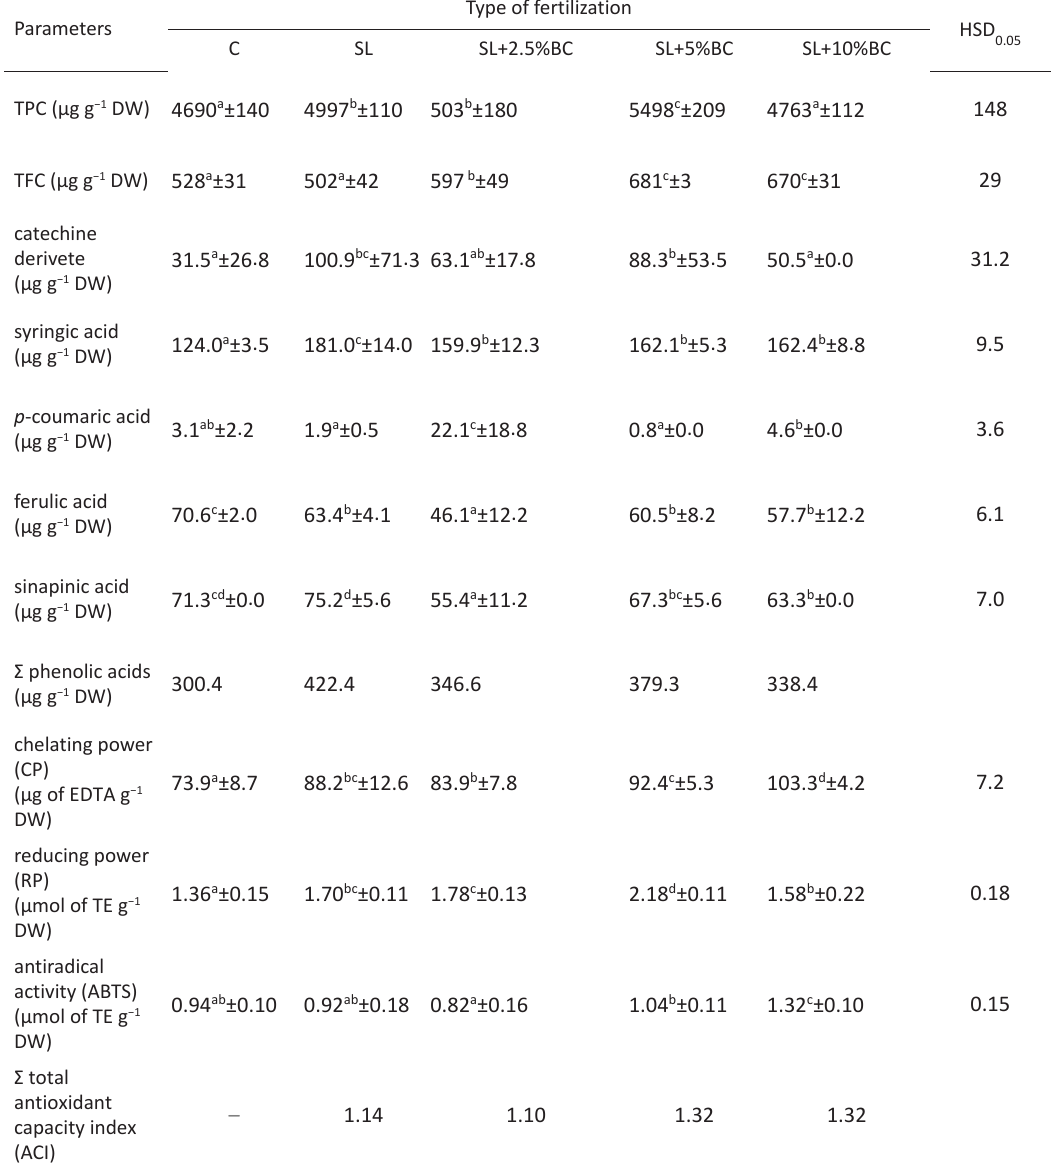
Table 3. Effect of sewage sludge (SL) and biochar (BC) application to soil on the phenolics content and antioxidant capacity of spring wheat grain (mean, ±SD, n=3)